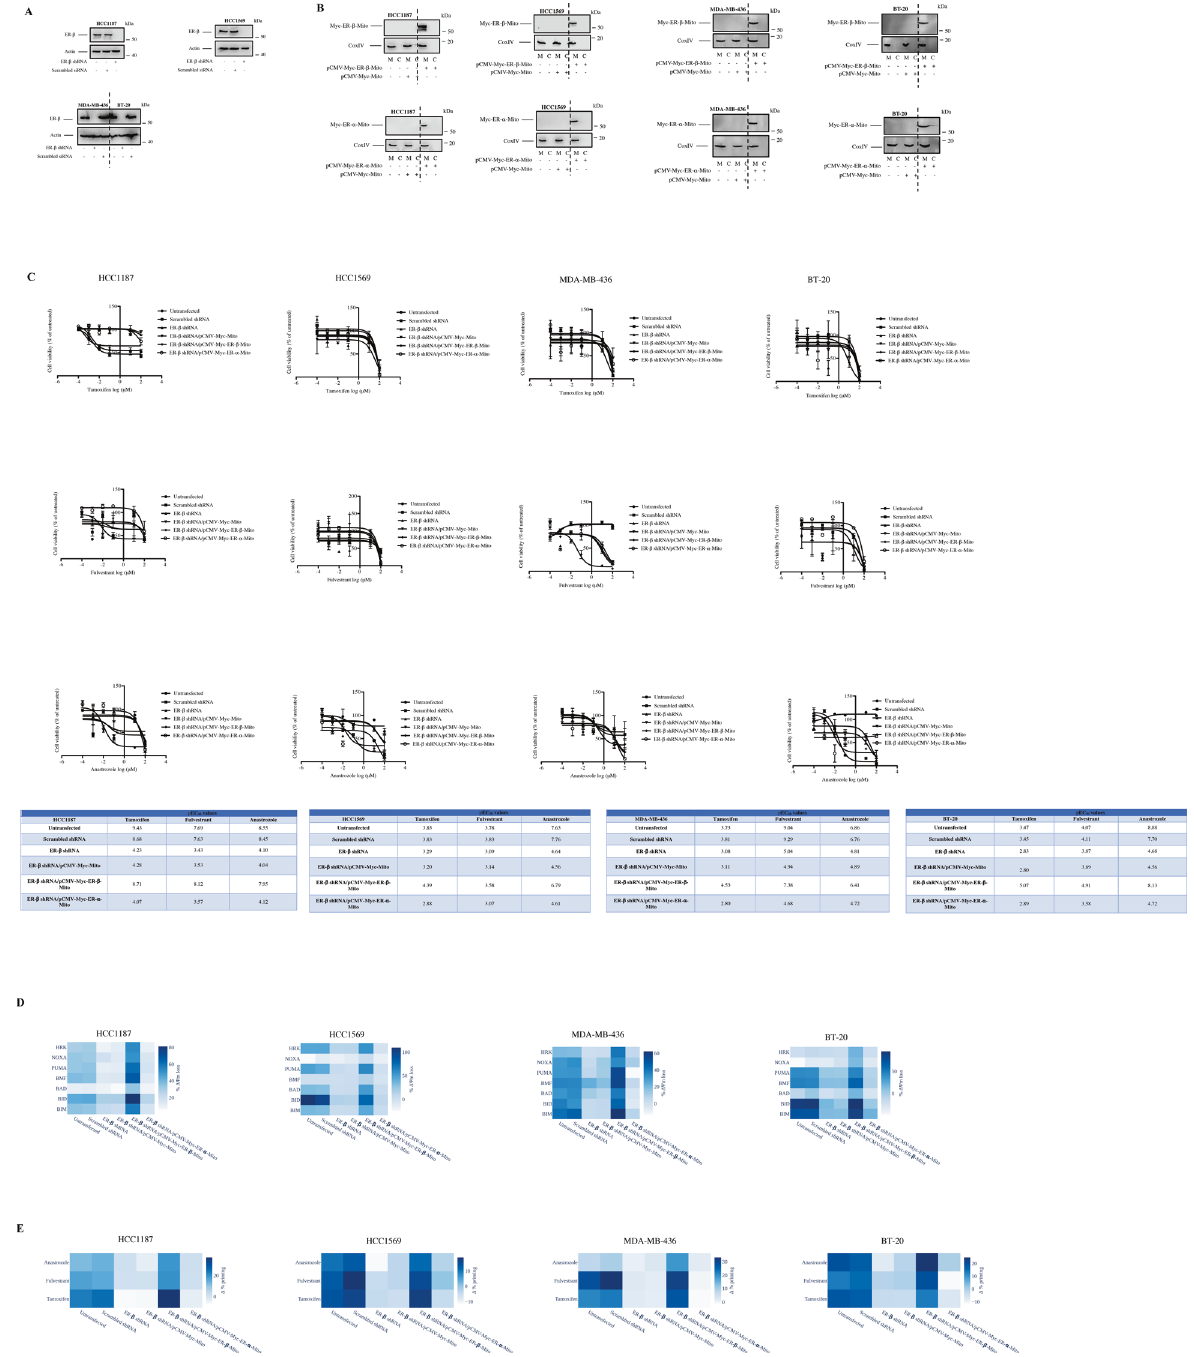
Fig. 5 Mitochondrial ER- β prominently alters the response to endocrine therapy in breast cancer cells. A ER- α -negative HCC1187, HCC1569, MDA-MB-436, and BT-20 cells were transfected with ER- β shRNA or scrambled shRNA to knockdown ER- β . The ef fi ciency of knockdown was evaluated by using immunoblotting. Actin was probed as loading control. ER- β -silenced HCC1187, HCC1569, MDA-MB-436, and BT-20 cells were transfected with pCMV-Myc-Mito, pCMV-Myc-ER- β -Mito, and pCMV-Myc-ER- α -Mito vectors. Mitochondrial expression of Myc-ER- β -Mito and Myc-ER- α -Mito was con fi rmed by immunoblotting using Myc-Tag antibody. COXIV was probed as loading control for mitochondrial fractions. B Untransfected, scrambled shRNA-transfected, ER- β shRNA-transfected, ER- β shRNA plus pCMV-Myc-Mito- transfected, ER- β shRNA plus pCMV-Myc-ER- β -Mito-transfected, and ER- β shRNA plus pCMV-Myc-ER- α -Mito-transfected cells were treated with tamoxifen, fulvestrant, and anastrozole for 48 h, and cell viability was evaluated by CellTiter-Glo assay (mean ± SEM, n = 3). EC 50 values of cells were determined by nonlinear regression analysis and pEC50 values were shown in the tables. Heat-map graphs of ( C ) BH3 pro fi les and ( D ) dBH3 pro fi les of untransfected, scrambled shRNA-transfected, ER- β shRNA-transfected, ER- β shRNA plus pCMV-Myc-Mito-transfected, ER- β shRNA plus pCMV-Myc-ER- β -Mito-transfected and ER- β shRNA plus pCMV-Myc-ER- α -Mito-transfected cells.